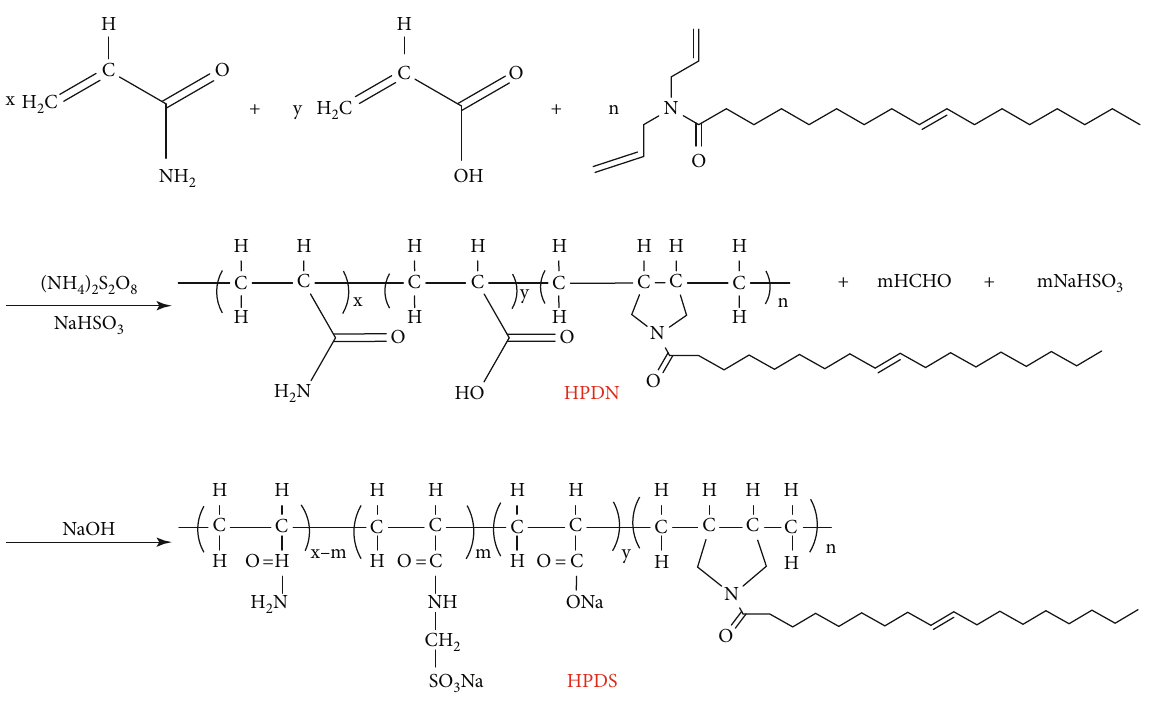
Scheme 1: The synthesis of